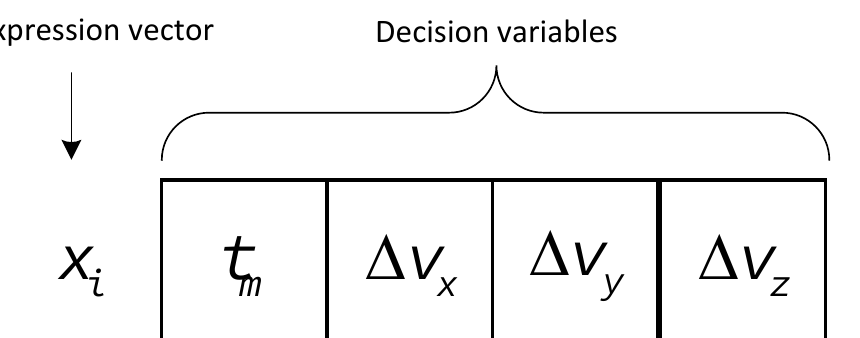
Figure 4. An illustration of the chromosome